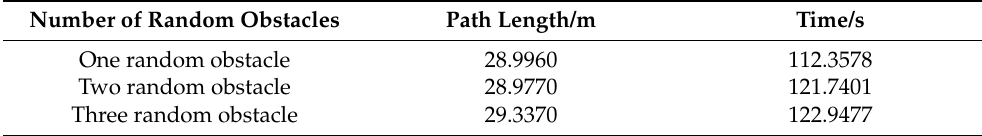
Figure 4. Path planning trajectory diagram of random obstacle avoidance: ( a ) Path planning without random obstacles; ( b ) Path planning when adding one random obstacle; ( c ) Path planning when adding two random obstacles; ( d ) Path planning when adding three random obstacles. Table 3. Path planning performance of improved A* algorithm fusing dynamic window